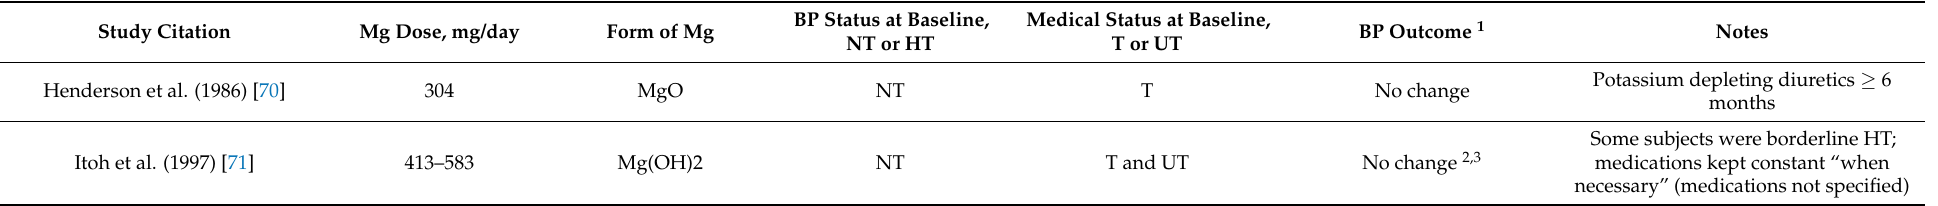
Table 3. Summary of magnesium supplementation studies for blood pressure in Controlled Hypertensives (subjects treated with antihypertensive medications, normotensive at